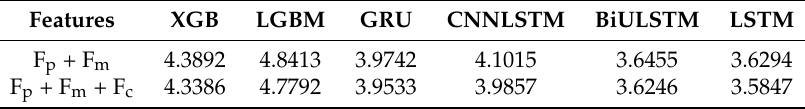
Table 1. Models’ average MAE values (µg/m 3 ) with/without CMAQ features.